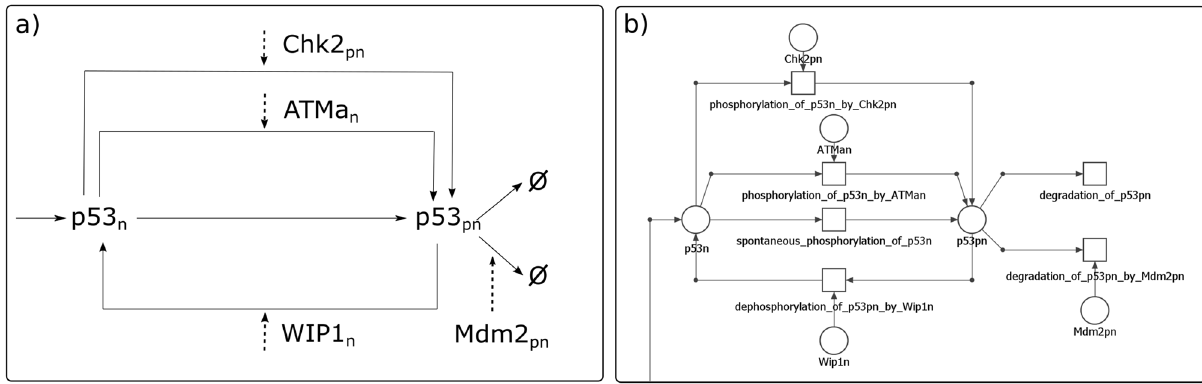
Figure 1. ODE-based wiring diagram vs. Petri net